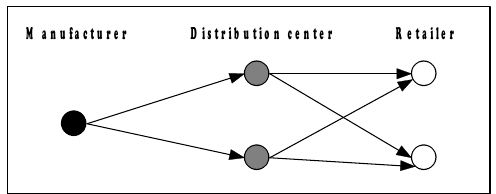
Figure 7. The example of typical supply chain